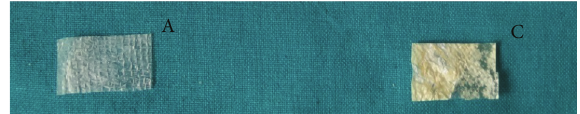
Figure 1: Lyophilized gamma irradiated amnion (A) and chorion (C) membranes, prepared to be used in periodontal therapy.